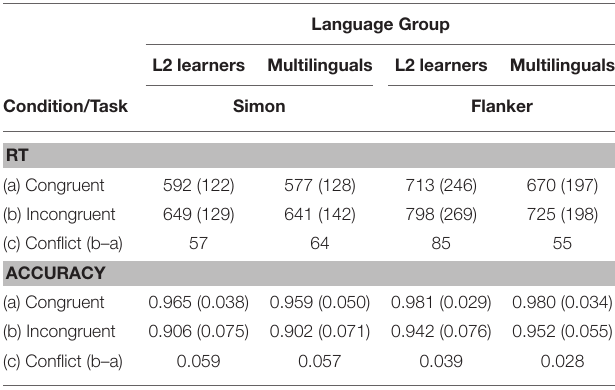
TABLE 2 | Mean RT and accuracy scores (and standard deviations) in Simon and Flanker task by language group. Language